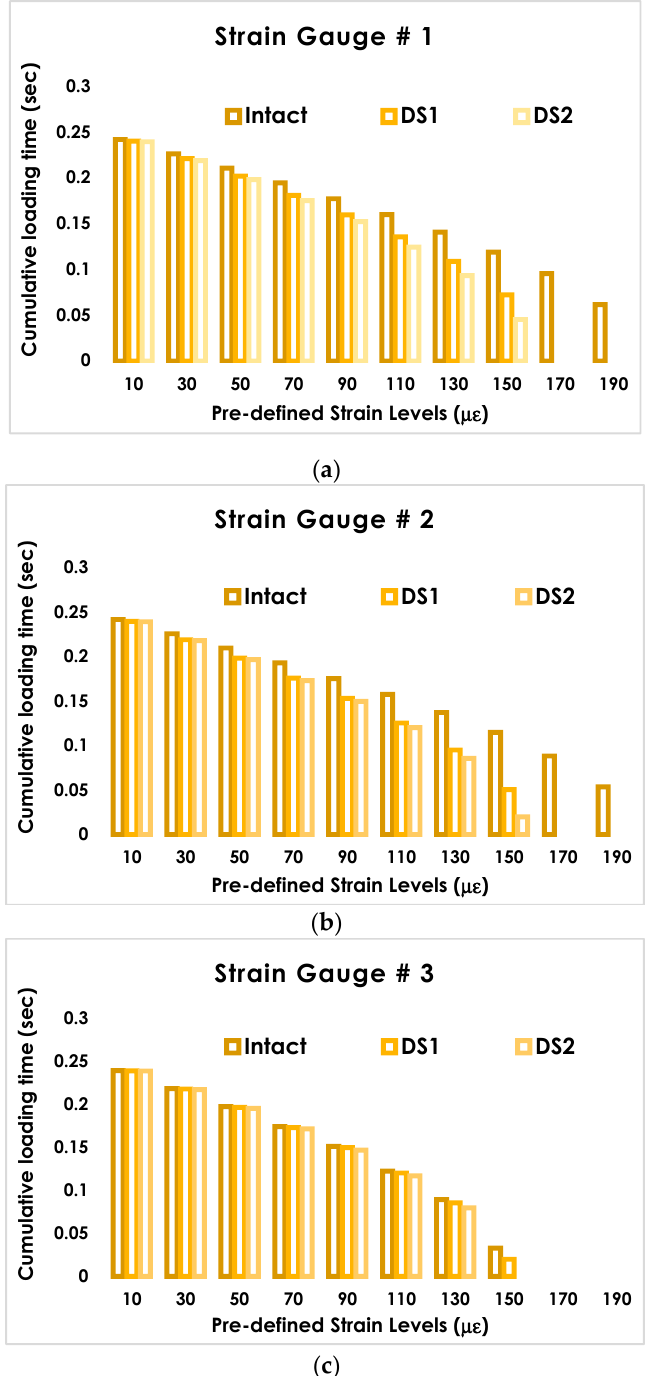
Figure 6. Cumulative time versus predefined strain levels for the intact and damaged states. (a) strain gauge # 1 (b) strain gauge # 2, and (c) strain gauge # 3.